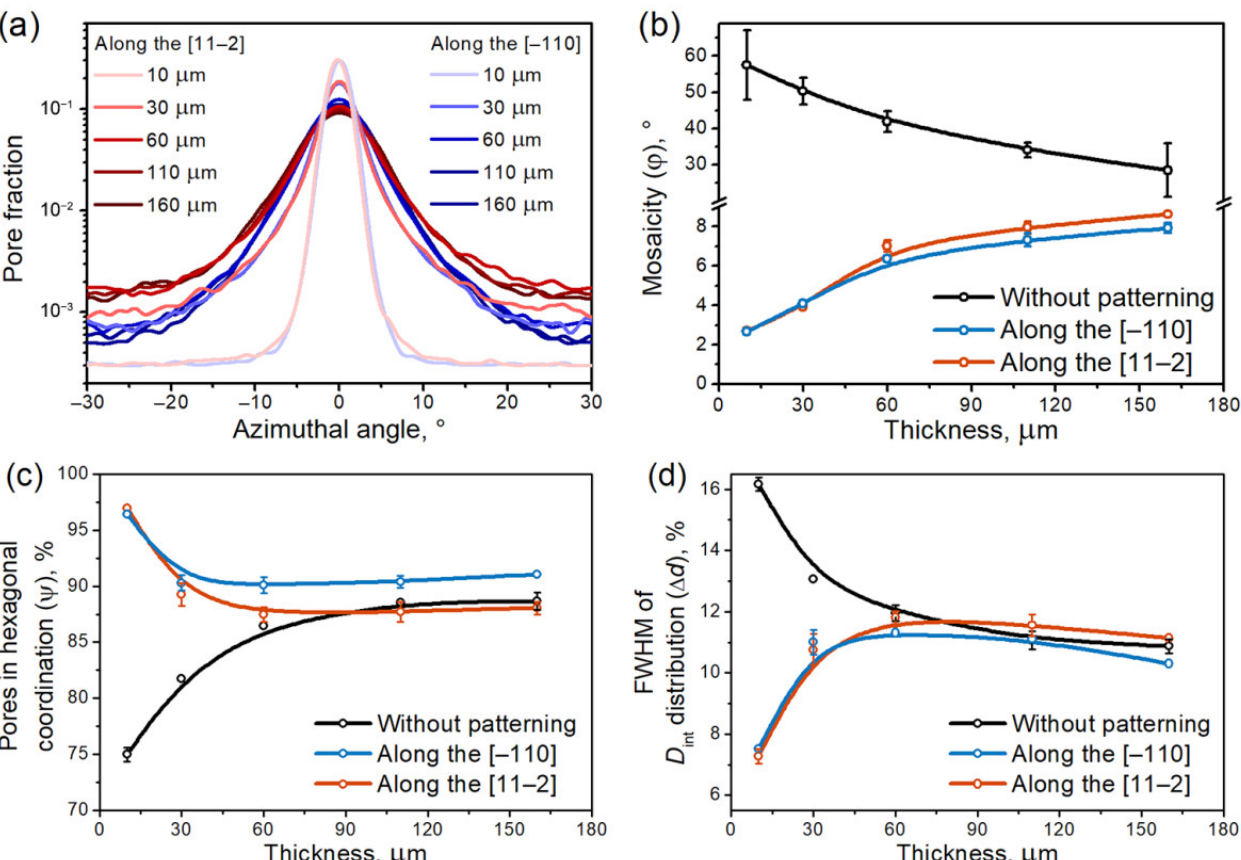
Figure 3. Thickness-dependent degree of pore ordering in anodic aluminum oxide (AAO) formed by anodization of pre-patterned Al(111) single crystals. ( a ) Azimuthal orientation distributions of hexagons formed by the six nearest neighbors of the considered pore, ( b ) the mosaicity of the porous structure, ( c ) the fraction of pores in hexagonal coordination, and ( d ) the FWHM of interpore distance ( D int ) distribution. The error bars correspond to the standard deviation values calculated from at least four SEM images each containing about 5 × 10 4 pores. The B-spline curves in ( b – d ) are given to guide the eye.